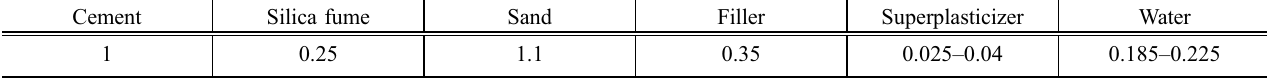
Table 1 Mix composition of UHPC (without steel fiber).